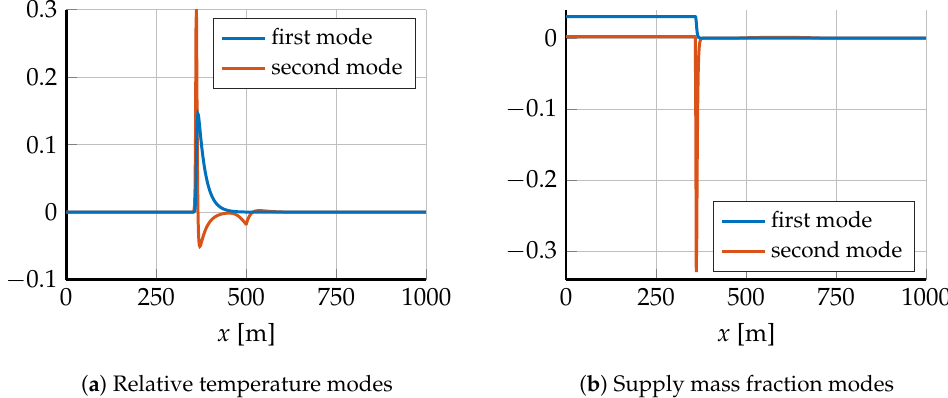
Figure 2. The first two (normalized) modes for the left combustion wave for the relative temperature and the supply mass